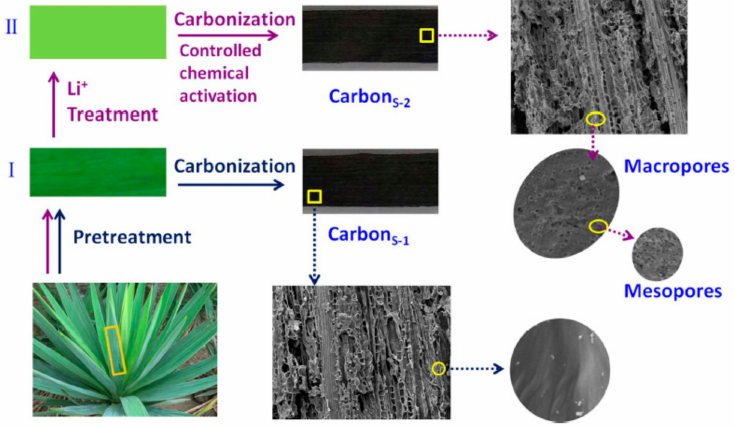
Figure 10. The preparation of porous biochar via simultaneous carbonization and controlled chemical activation. Reprinted from Reference